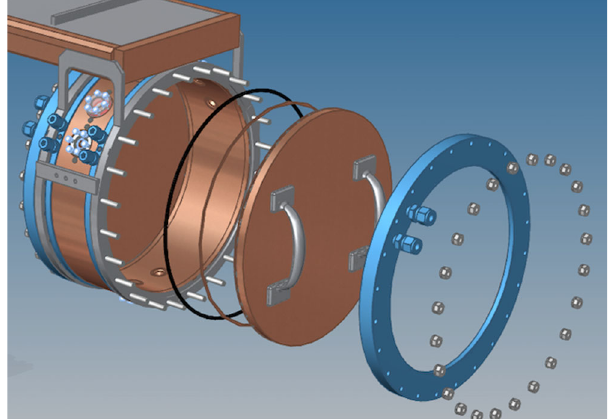
FIG. 4. Exploded view of cavity, illustrating assembly. From left to right, components include: cavity body; Viton O-ring for vacuum seal; annealed copper gasket for rf seal; modular endplate (made of copper or beryllium in this work); removable handles for endplate installation; stainless steel clamping ring with integrated water cooling lines; nuts to apply clamping pressure, threaded onto studs mounted on cavity body.